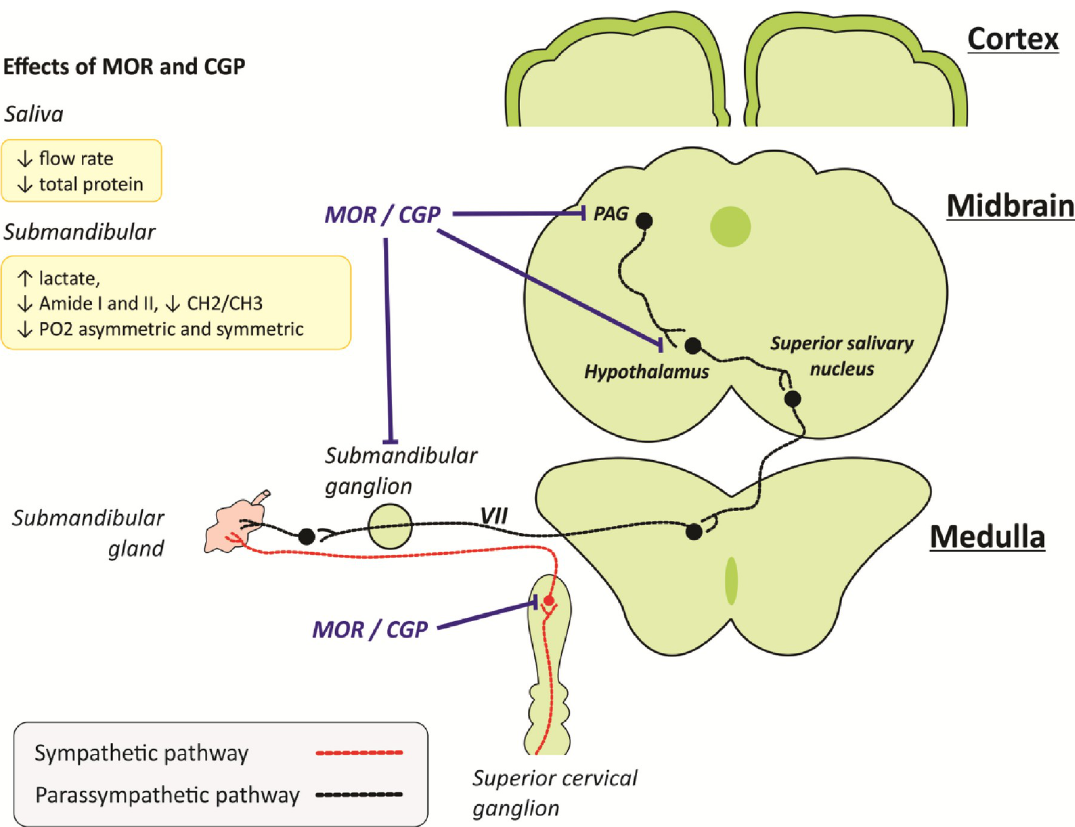
Fig 6. Schematic draw of a proposed pathway for morphine- and CGP-induced regulation of midbrain and autonomic ganglions. Arrows indicate the salivary and submandibular gland contents regulations ( " increase, # decrease) under morphine or CGP treatments. Blue line indicates the inhibitory effect of morphine and CGP to autonomic pathway to submandibular glands. Red and black lines indicate the sympathetic and parasympathetic pathway to submandibular gland. Opioid receptors are expressed in PAG [51], hypothalamus [52,53],submandibular ganglia [18,46]and superior cervical [41,42] ganglia. CGP, cyclo-Gly-Pro.